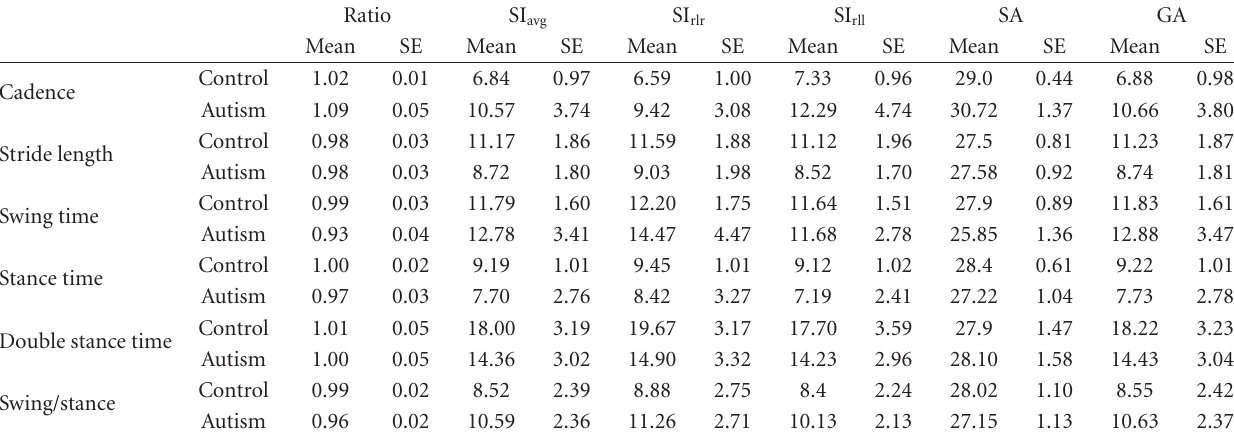
Table 3: Descriptive statistics (mean and standard error) for the symmetry indices for the autism and age-matched control